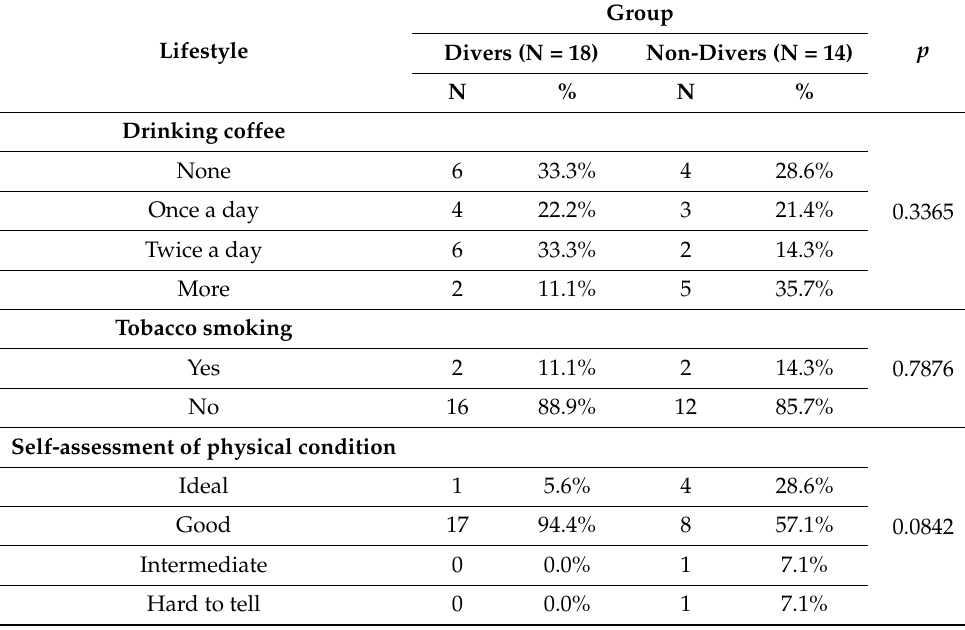
Table 3. Subject